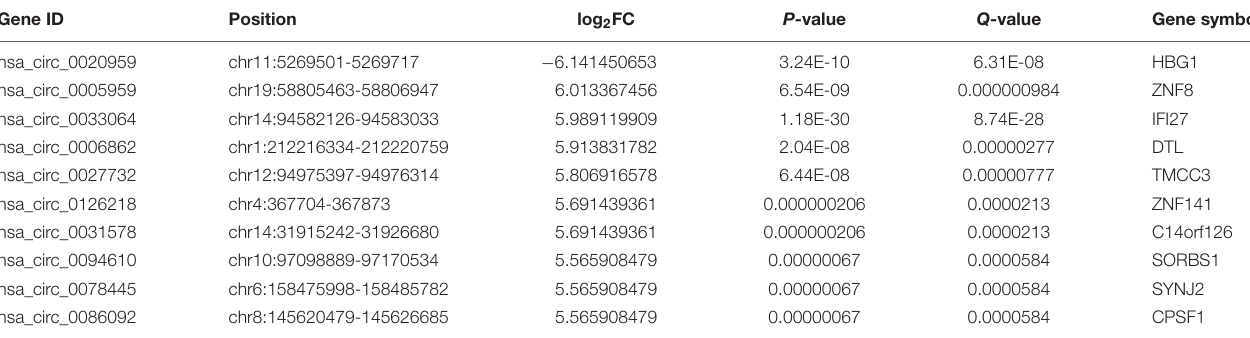
TABLE 1 | Top 10 differentially expressed circRNAs between two groups. Gene ID